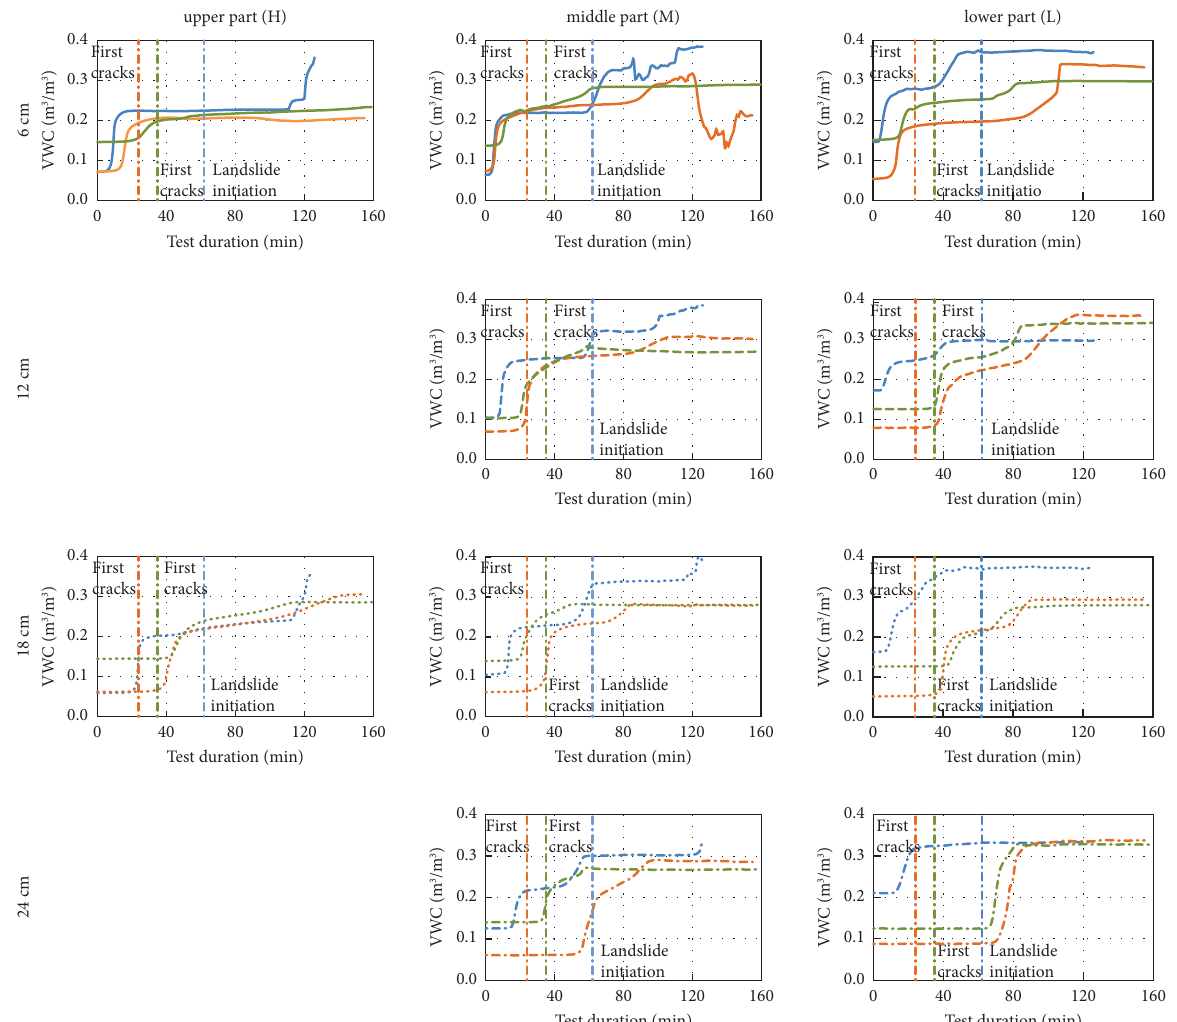
Figure 6: Volumetric water content (VWC) in Test 1 (blue), Test 2 (orange), and Test 3 (green) in the upper (H), middle (M), and lower (L) part of the slope at 6 cm, 12cm, 18 cm, and 24cm depth from the slope surface.